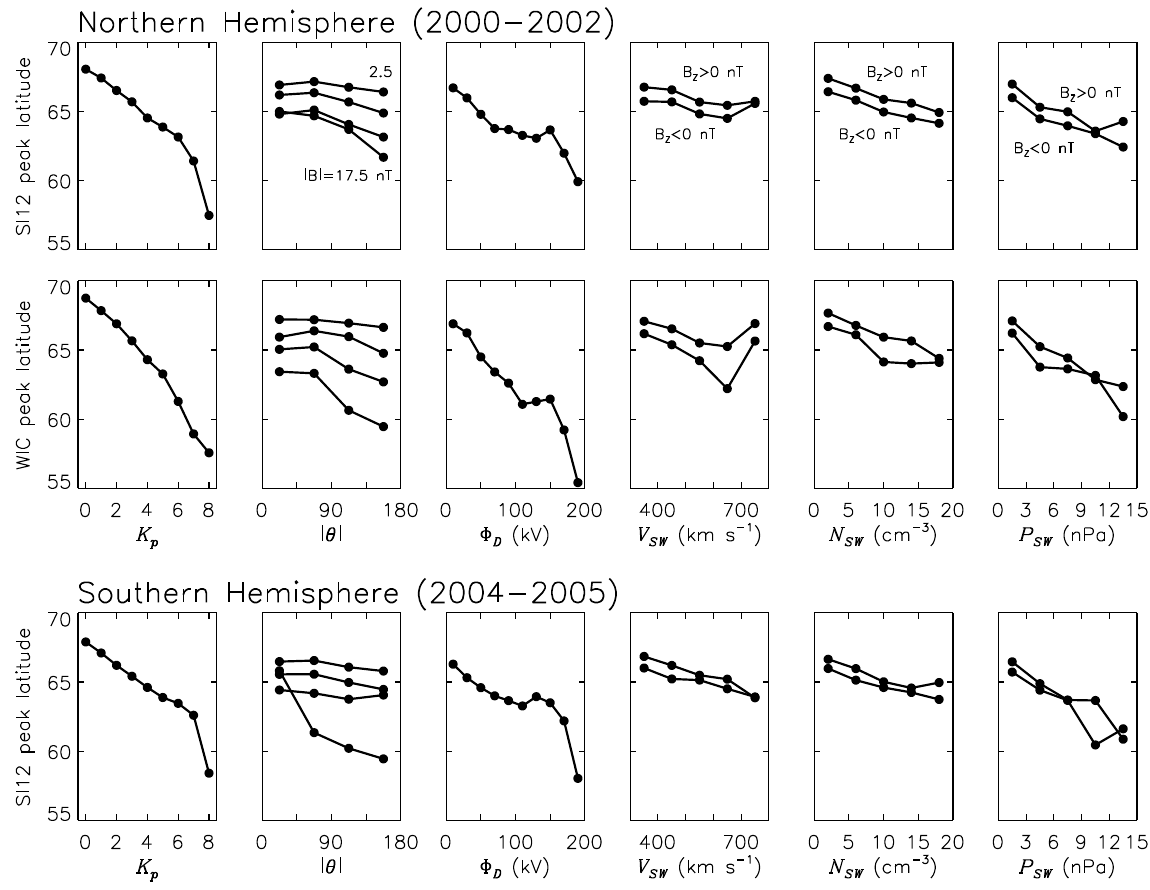
Fig. 5. Similar to Fig. 4, indicating the latitude of the peak in auroral brightness along the midnight meridian.